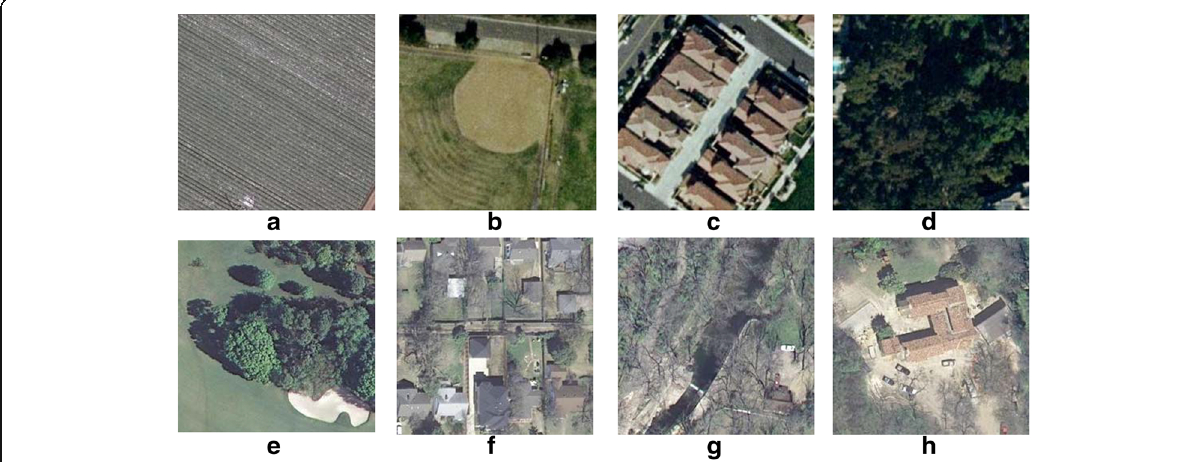
Fig. 4 Eight scene images from the UC Merced Land-Use dataset: a agriculture, b baseball diamond, c dense residential, d forest, e golf course, f medium residential, g river, and h sparse